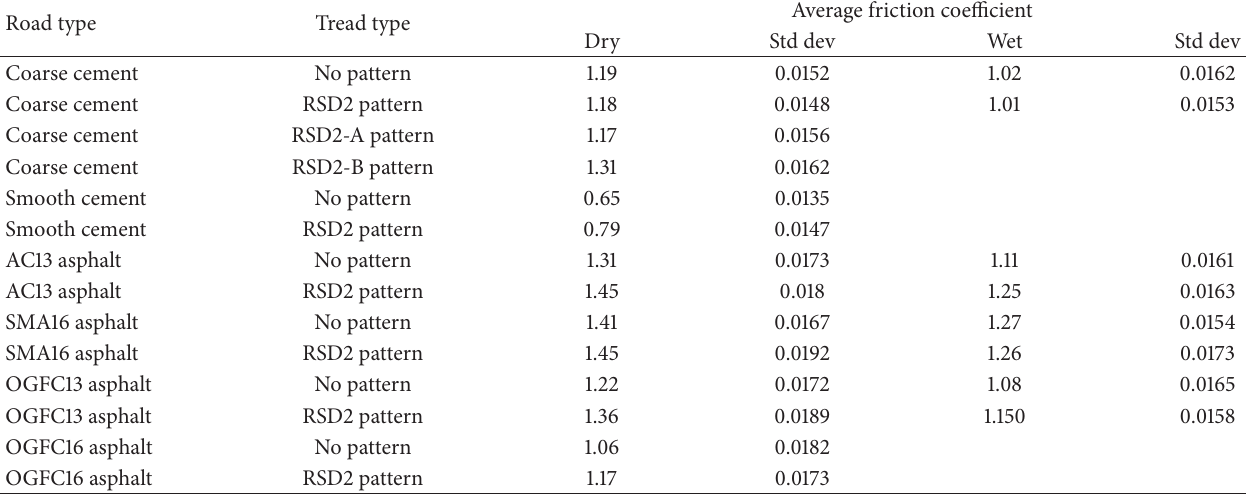
Table 2: Average friction coefficients.